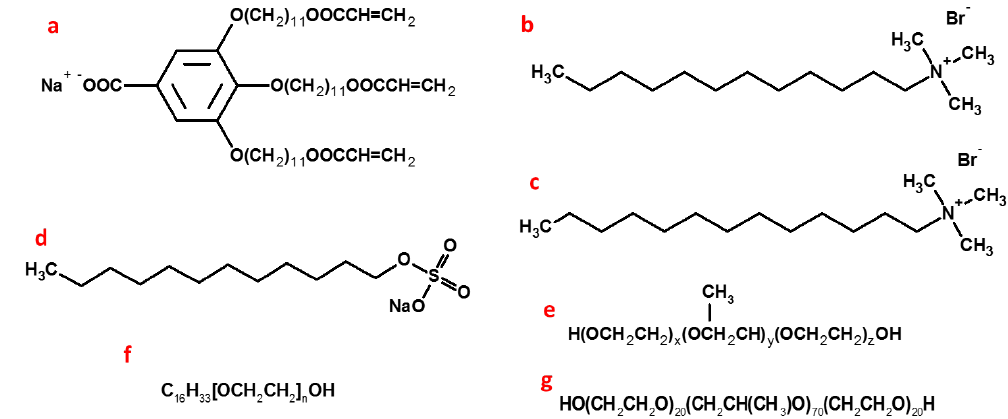
Figure 8. Molecular structure of natural and synthesized amphiphiles mainly used as structure directing agents for hexagonal LLCs. ( a ): NA-GA3C11; ( b ): DTAB; ( c ): Cetyltrimethylammonium bromide (CTAB); ( d ): Sodium dodecyl sulphate (SDS); ( e ): P123; ( f ): Brij56; ( g ): F127.